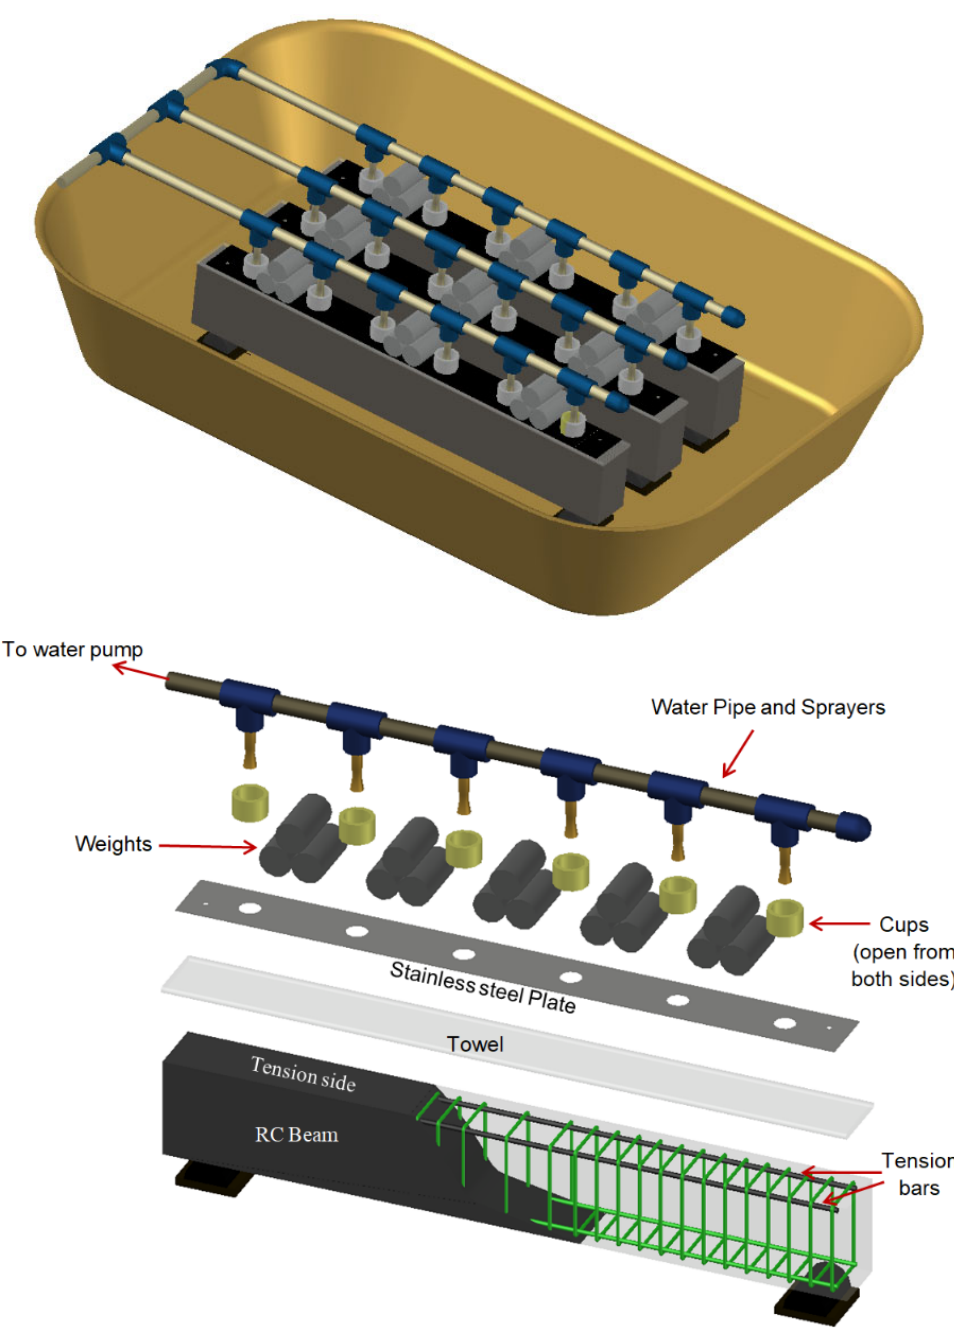
Figure 1. 3D schematic drawing of components of the corrosion setup.